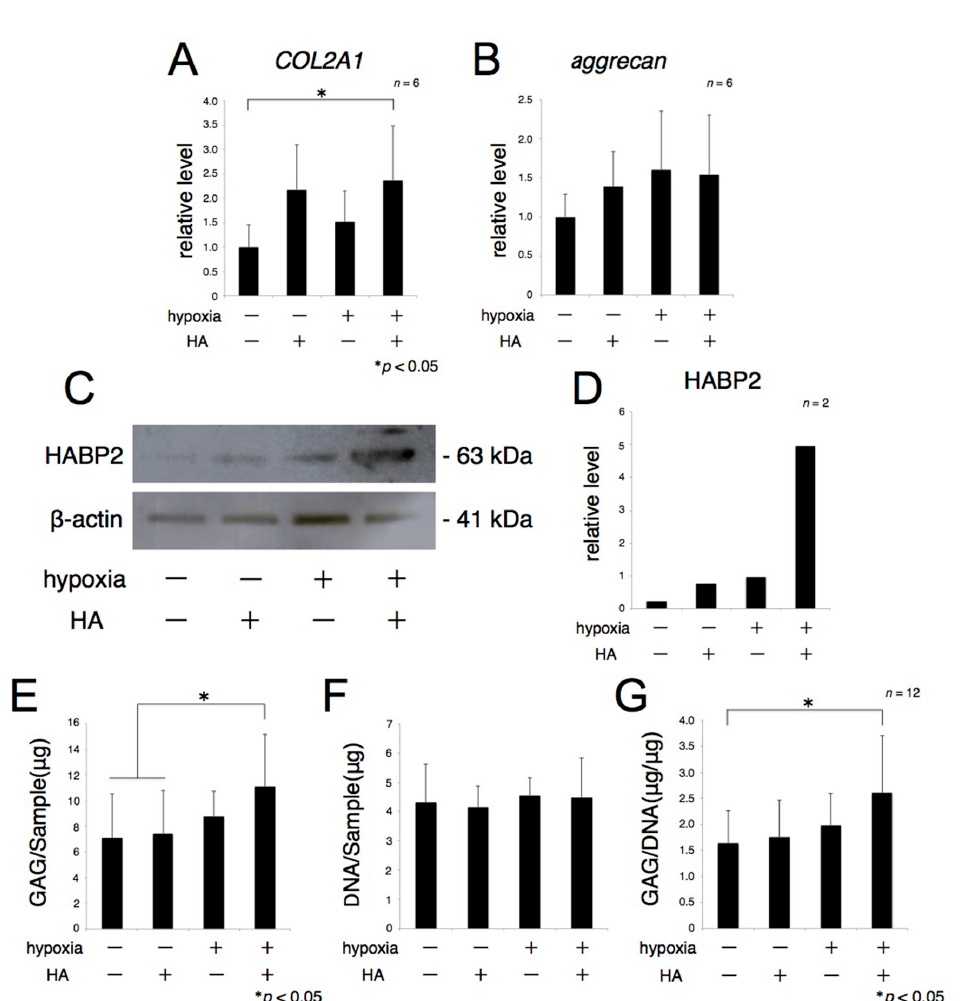
Figure 1. Exogenous hyaluronic acid (HA) promotes extracellular matrix (ECM) metabolism